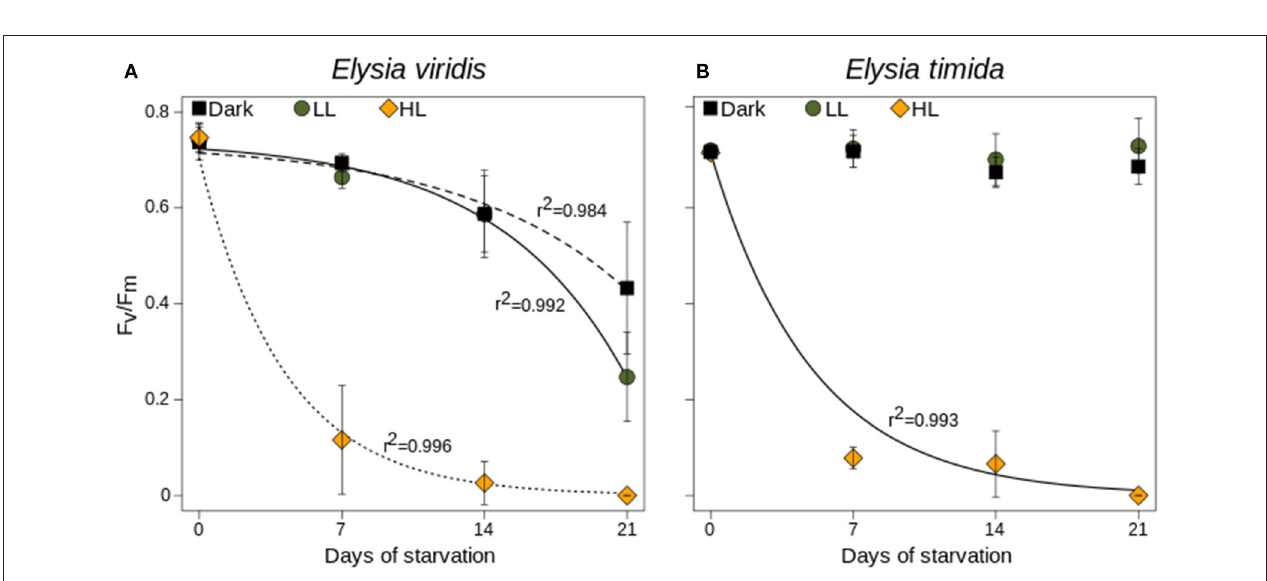
FIGURE 3 | relF v /F m and NPQ of kleptoplasts of freshly fed E. timida (A,B) under 239 µ mol photons m − 2 s − 1 freshly fed (green circles), starved for 1 week (orange squares) and 3 weeks (blue diamonds). The bar represents the dark acclimation phase (first black part), the light exposure time (white part) and the recovery phase (second black part). All measurements were performed in biological triplicates and error bars show the standard deviation.